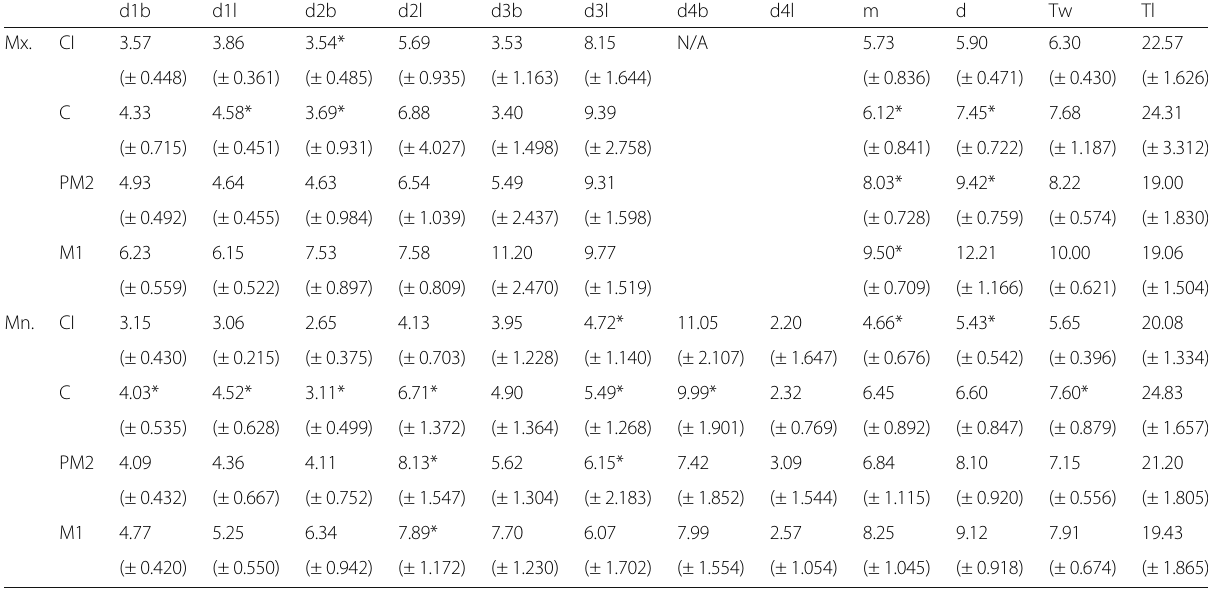
Table 2 Horizontal width of alveolar bones (d1, d2, d3, d4), (m, d), and tooth dimensions (Tw,